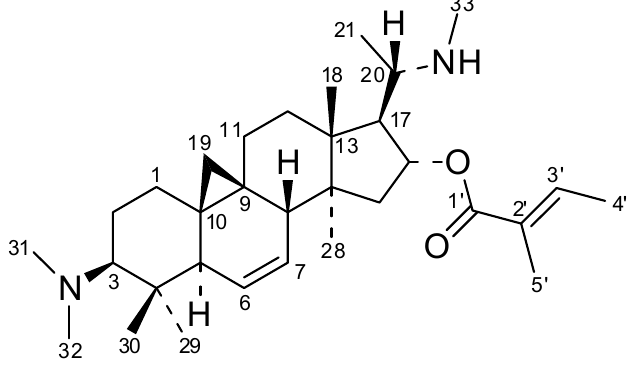
Figure 3. Structure of O -tigloylcyclovirobuxeine-B ( 1 ).